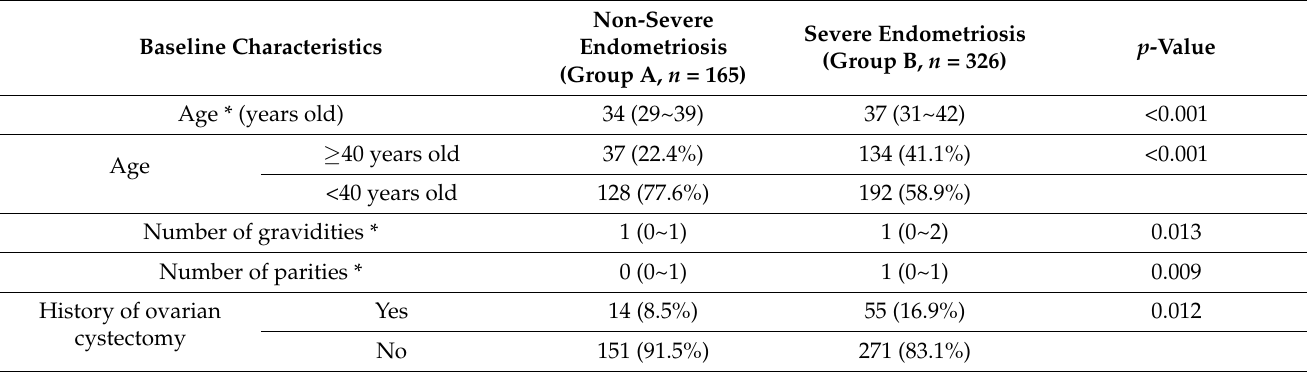
Table 1. Baseline characteristics of 491